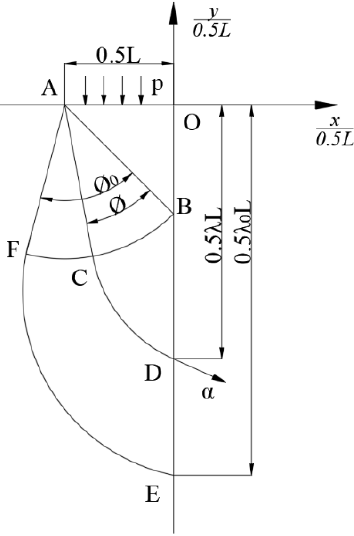
Figure 4. Slip line field during the forming process. ter : thickness ratio discs. The slip line field during the form- ing process is shown in Fig. 4. Where y is the ordinate, 0 . 5 L x is the abscissa, and λ = y . When the ordinate of a 0 . 5 L 0 . 5 L point D on the centre line of the deformation area is γ , (cid:54) BAC of the corresponding sector field is ∅ . When y = h a and 2 λ 0 = h a , h a is the initial height of the workpiece, L is the L width of the contact area between the cone roll and the work- piece, and (cid:54) BAF of the corresponding sector field is ∅ 0